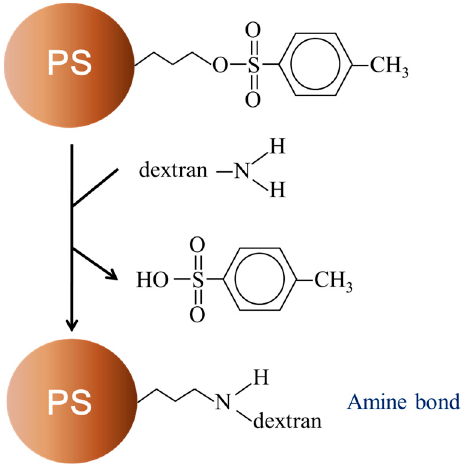
Figure 1. Reaction scheme between amino-dextran and tosyl-activated magnetic particles (Dynabeads ® ), which are coated with polystyrene (PS).